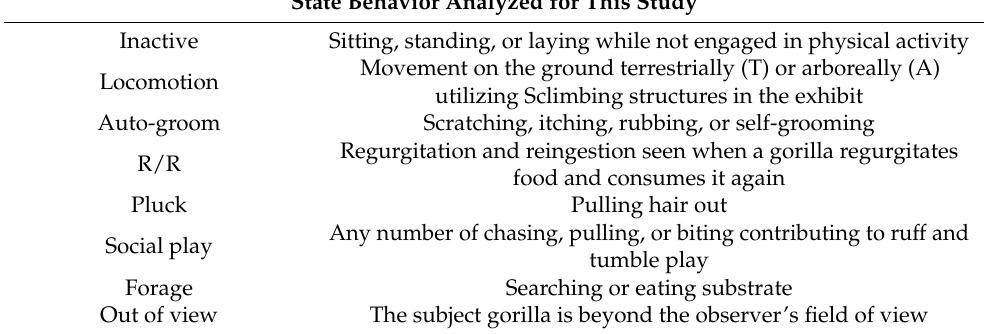
Table 2. Ethogram of behaviors that was analyzed for the present study. Behaviors that were excluded from analyses included those that were rare (comprising <5% of the activity budget), and those that were not relevant to the current study (i.e., orient to humans when no visitors were present) and have been omitted here for clarity. State Behavior Analyzed for This Study Inactive Sitting, standing, or laying while not engaged in physical activity Movement on the ground terrestrially (T) or arboreally (A) Locomotion utilizing Sclimbing structures in the exhibit Auto-groom Scratching, itching, rubbing, or self-grooming Regurgitation and reingestion seen when a gorilla regurgitates R/R food and consumes it again Pluck Pulling hair out Any number of chasing, pulling, or biting contributing to ruff and Social play tumble play Forage Searching or eating substrate Out of view The subject gorilla is beyond the observer’s field of